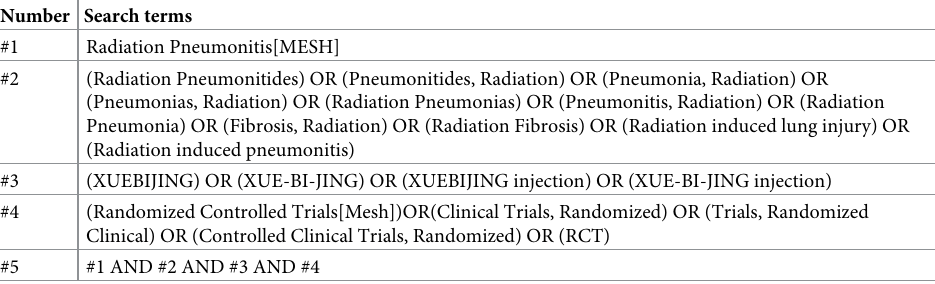
Table 1. Search strategy for